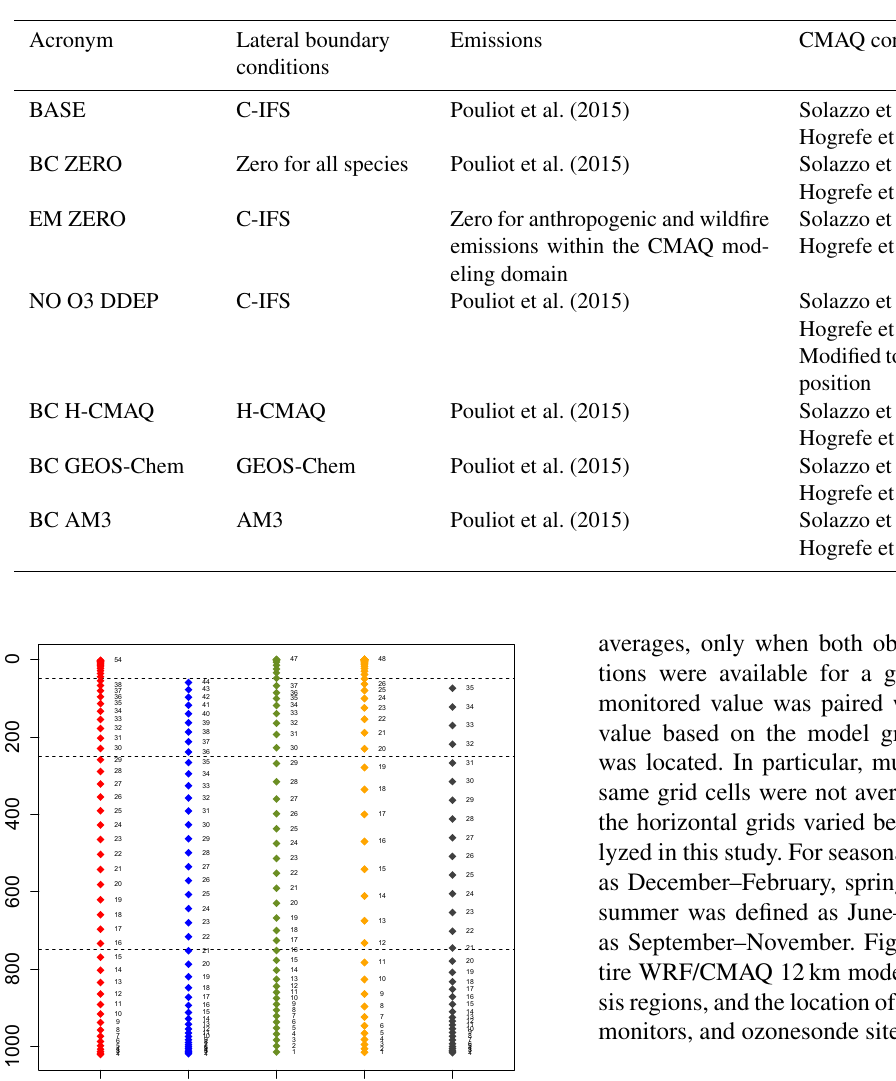
Table 2. List of regional-scale CMAQ simulations.